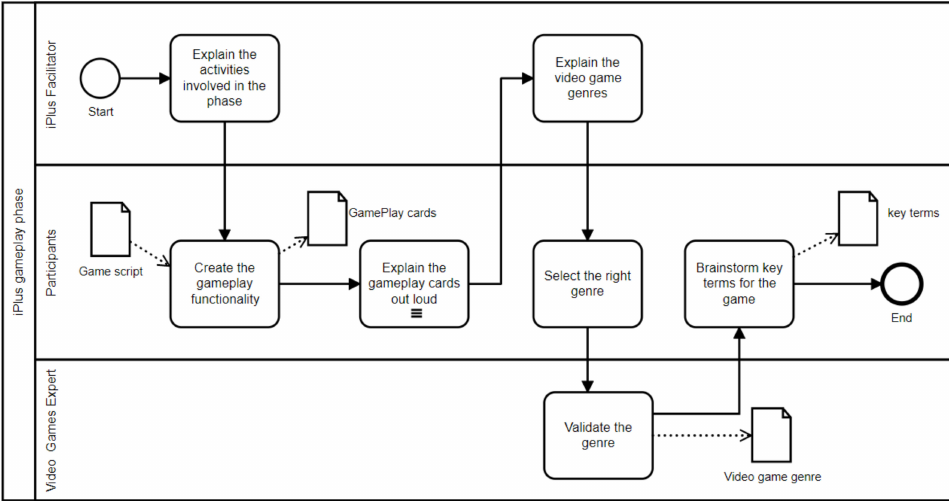
Figure 7. GamePlay Phase